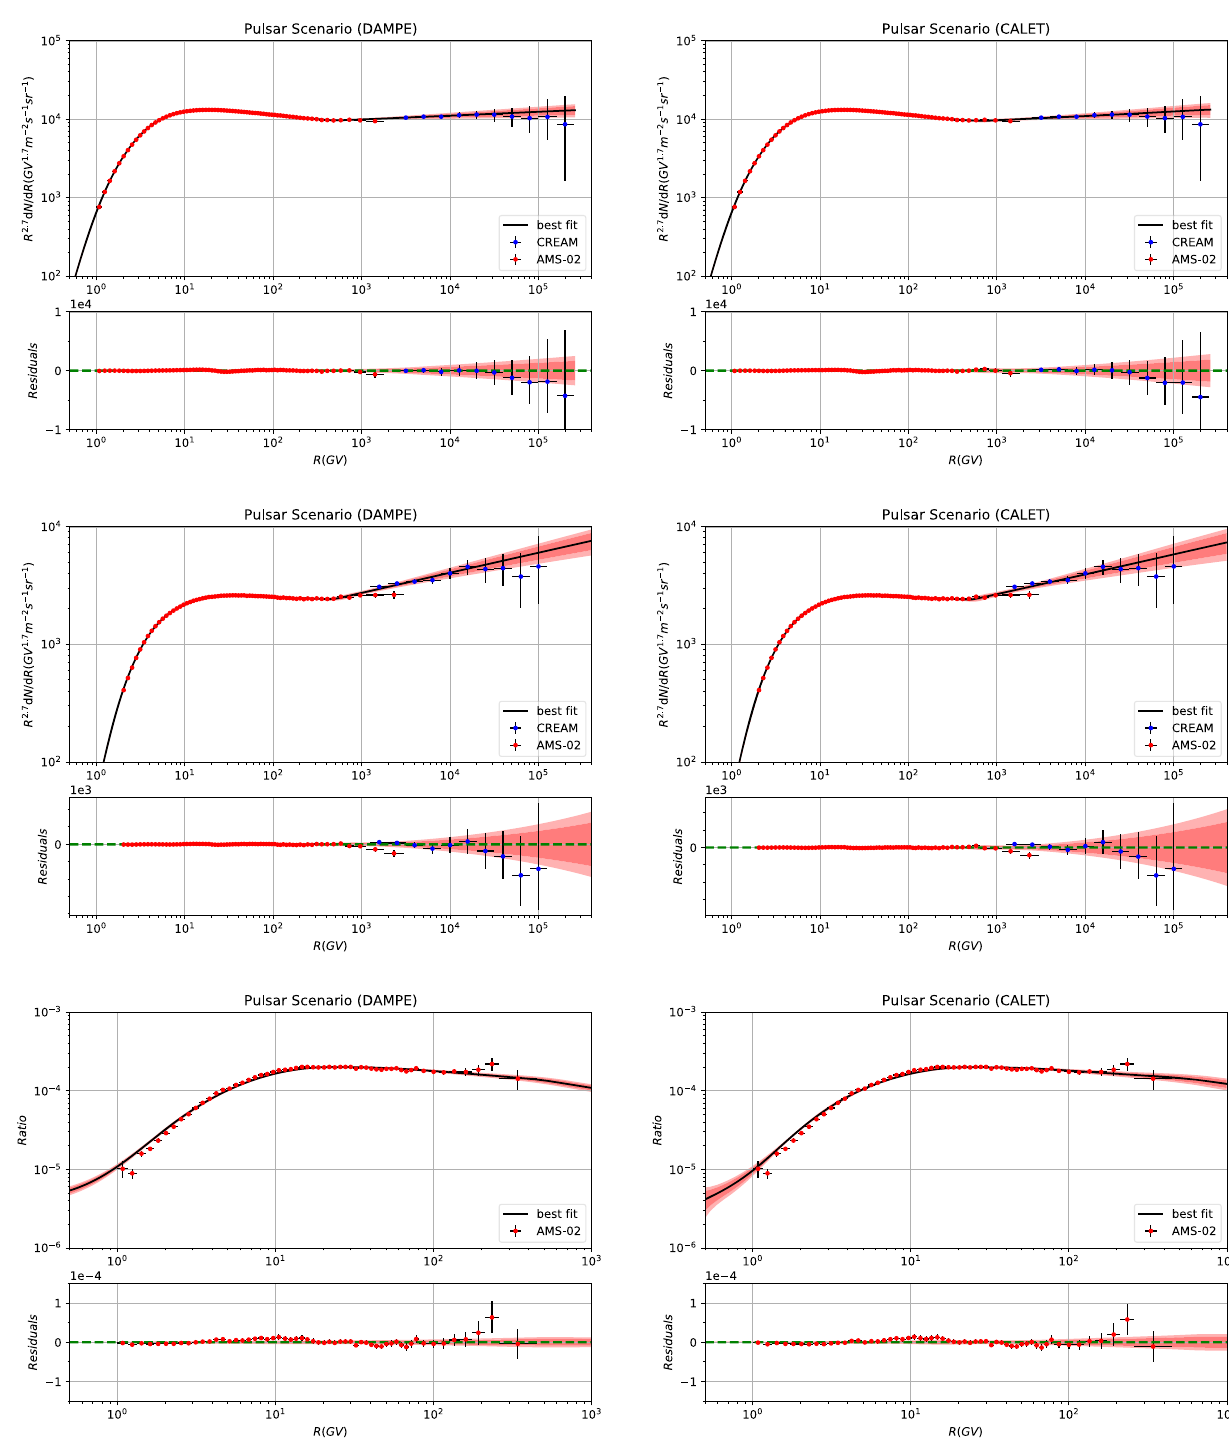
Fig. 5 The global fitting results and the corresponding residuals to the proton flux, helium flux, ¯ p / p ratio, and positron flux for two scenarios. The 2 σ (deep red) and 3 σ (light red) bound are also showed in the